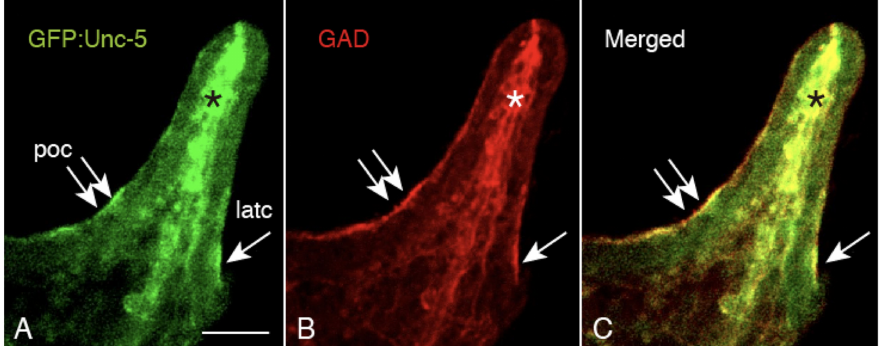
Figure 7. Confocal laser scanning microscopy of 4dpf-4aPL shows co-expression of Unc-5 and GAD at the CBASs. ( A ) GFP:Unc-5-positive post-oral CBAS (poc) and lateral CBAS (latc). Asterisk: GFP:Unc-5-positive cells in the blastocoel. ( B ) GAD-positive, same area as (A). Inset: GAD-positive cells in the blastocoel. ( C ) Merged image between (A) and (B). Double arrows: poc; single arrow: lateral CBAS. Scale bar = 30 µ m.